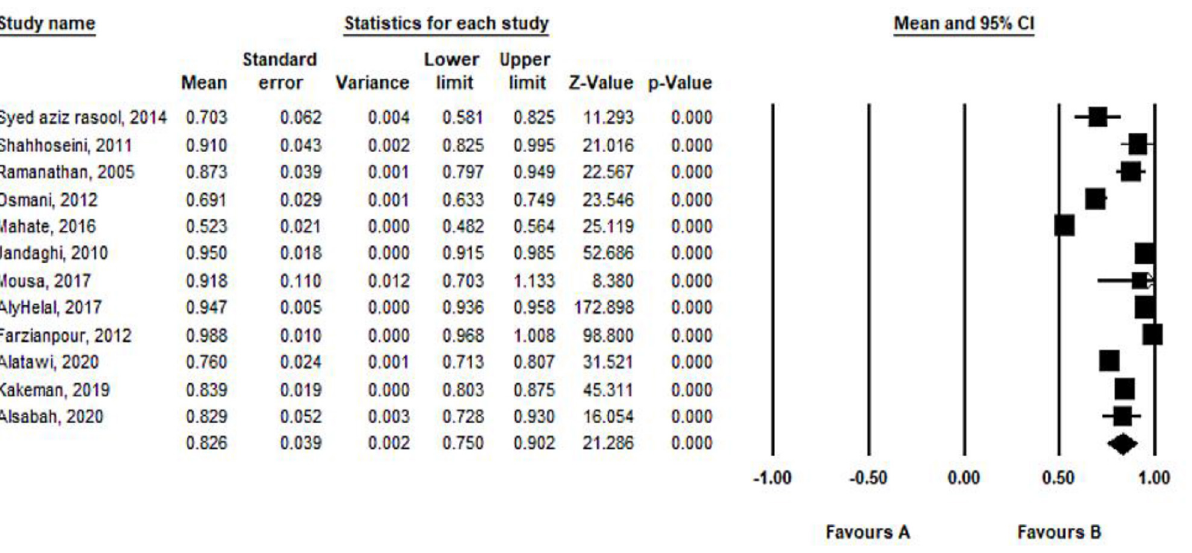
FIGURE3 Mean and standard deviation of TE with CRS model in included studies based on the random-effects